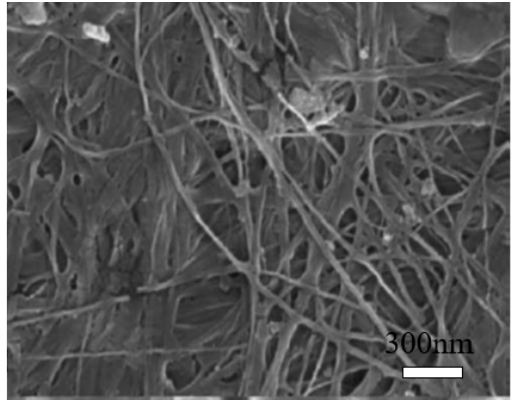
Figure 4. Scanning electron microscopy (SEM) image of bacterial cellulose (BC). Reproduced from [45], with permission from Elsevier, 2015.